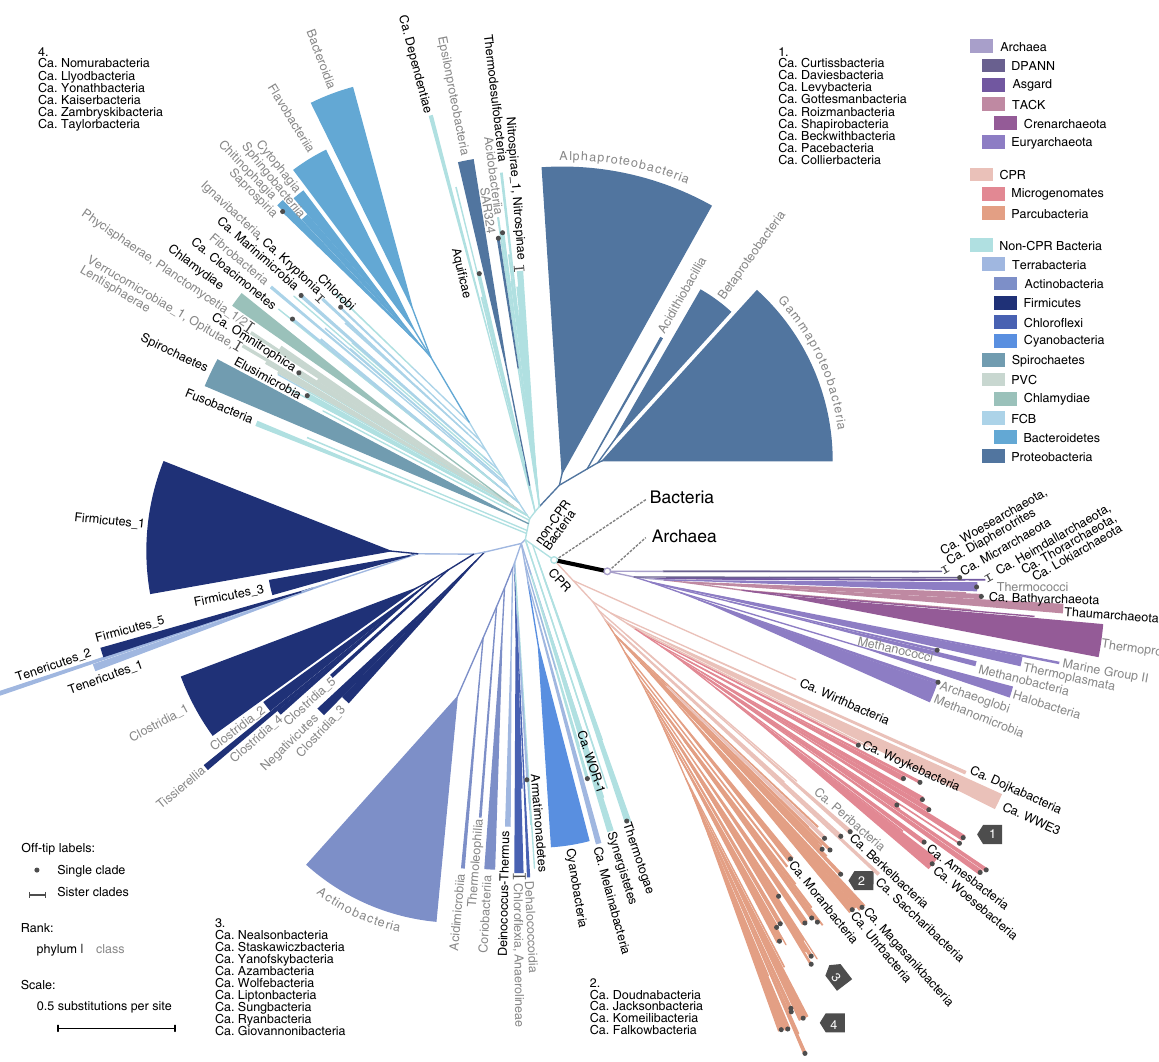
Fig. 1 A new view of the bacterial and archaeal tree of life. The tree contains 10,575 evenly distributed bacterial and archaeal genomes, with topology reconstructed using ASTRAL based on individual trees of 381 globally sampled marker genes, and branch lengths estimated based on 100 most conserved sites per gene. Branches with effective number of genes (en) ≤ 5 and local posterior probability (lpp) ≤ 0.5 were collapsed into polytomies. Taxonomic labels at internal nodes and tips re fl ect the tax2tree curation result. Color codes were assigned to above-phylum groups and phyla with 100 or more representatives. To display the tree in a page, it was collapsed to clades (sectors) representing phyla with at least one taxon (black), and classes with at least ten taxa (gray). The radius of a sector indicates the median distance to all descending taxa of the clade, and the angle is proportional to the number of descendants. For polyphyletic taxonomic groups, minor clades with <5% descendants of that of the most specious clade were omitted, while the remaining clades were appended a numeric suf fi x sorted by the number of descendants from high to low. Dots (single clade) and lines (sister clades) are used to assist visual connection between tips and labels, where necessary. In four instances where visual space is inadequate (marked by gray arrows), groups of labels in clockwise order are provided in remote blank areas. Source data are provided as a Source Data fi